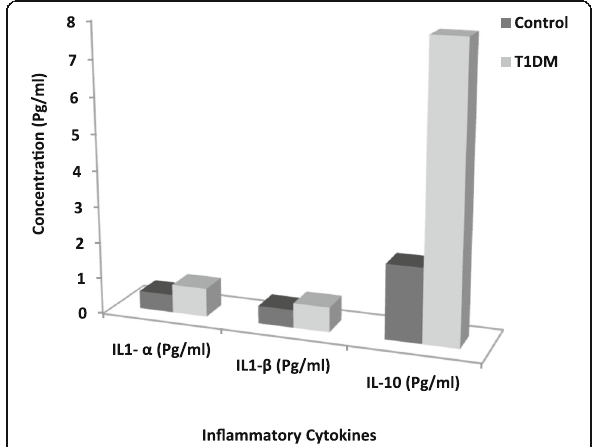
Fig. 1 Serum levels of inflammatory cytokines (IL-1 α , IL-1 β , and IL-10) in T1DM and